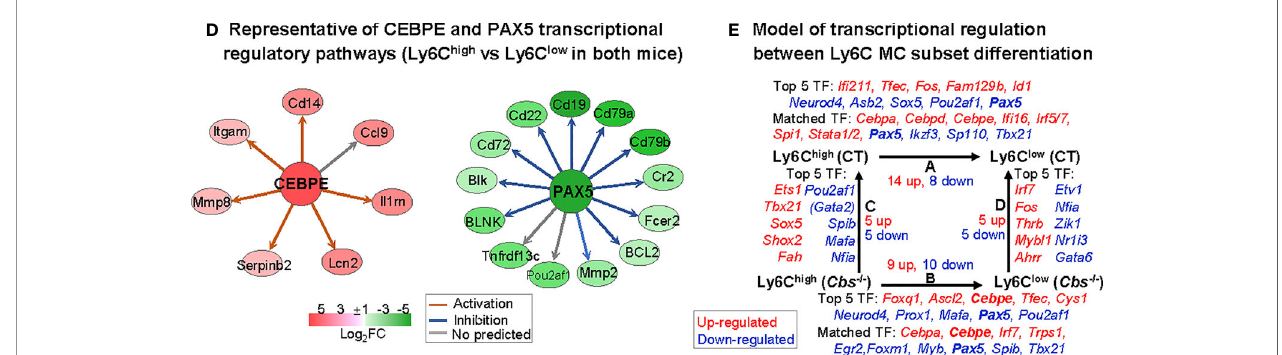
FIGURE 5 | Identi fi cation of SDE TF and immunological transcriptional regulatory models. (A) SDE TF in four comparison groups. Volcano plot of all genes demonstrates the expression pattern of SDE TF in four comparison groups. Down-regulated SDE TF are highlighted in green and up-regulated in red (|Log 2 FC|>1, adj. P <0.01), with Log 2 FC as x-axis and − Log 10 (adjust P -value) as y-axis. Top 25 up- and down-regulated SDE TF in all comparisons via IPA are listed in Supplementary Table 2 . (B) Overlap analysis for SDE TF in Ly6C MC subsets and top pathways. Venn diagram summarized the total SDE genes and their top 3 pathways in each SDE TF change groups from four pairs of comparisons. Functional pathways were developed by metascape software using the GO database only in SDE set (>20 SDE genes). The top 3 functional pathways are presented. Numbers depict the amount of SDE TF. Numbers in the parentheses describes the number of pathways. A detailed list of SDE TF and pathway in each SDE set are presented in Supplementary Table 3 . (C) SDE TF and targeted SDE immunological genes. SDE immunological genes were matched with SDE TF by IPA upstream analysis. Transcriptional regulatory relationship between SDE TF and SDE immunological genes was justi fi ed by correspondence at the same direction (either positive or negative) and overlapped p-value<0.01 and |z-score|>2. Note that Itgam is also known as CD11b, that Ly6c refers to other Ly6 genes (Ly6.2, Ly6C, Ly6C.2, Ly6C antigen, Ly6a2, Ly6al, Ly6b, Ly6c1, Ly6c2, Ly6f, Ly6g, Ly6i). (D) Representative of CEBPE and PAX5 transcriptional regulatory pathways (Ly6C high vs. Ly6C low in both mice) CEBPE and PAX5 are used as the representative SDE TF to establish transcriptional regulatory network by using IPA upstream analysis. The corresponding expression levels of targeted SDE genes are indicated by colored nodes. (E) Model of transcriptional regulation between Ly6C MC subset differentiation. Model describes potential transcriptional regulatory machinery. In Comparison A, 22 SDE TF (14 up-red and 8 down-blue) are identi fi ed in Ly6C high MC subset in CT mice. In Comparison B, 19 SDE TF (nine up and 10 down) are identi fi ed in Cbs -/- Ly6C high MC subset. In Comparison C, 10 SDE TF ( fi ve up and fi ve down) are identi fi ed in Cbs -/- Ly6C high MC subset. While, in Comparison D, 10 SDE TF ( fi ve up and fi ve down) are identi fi ed in Cbs -/- Ly6C low MC subset. Top 5 SDE TF are indicated in italic letters, and matched SDE TF in the parentheses. Red letter highlighted the representative up-regulated gene. Blue letter highlighted down-regulated genes. Abbreviations are as that in Figure 2 . RNAP, RNA polymerase, PID, pathway interaction database; HDAC, histone deacetylase. Abbreviation for gene names refer to list in website,